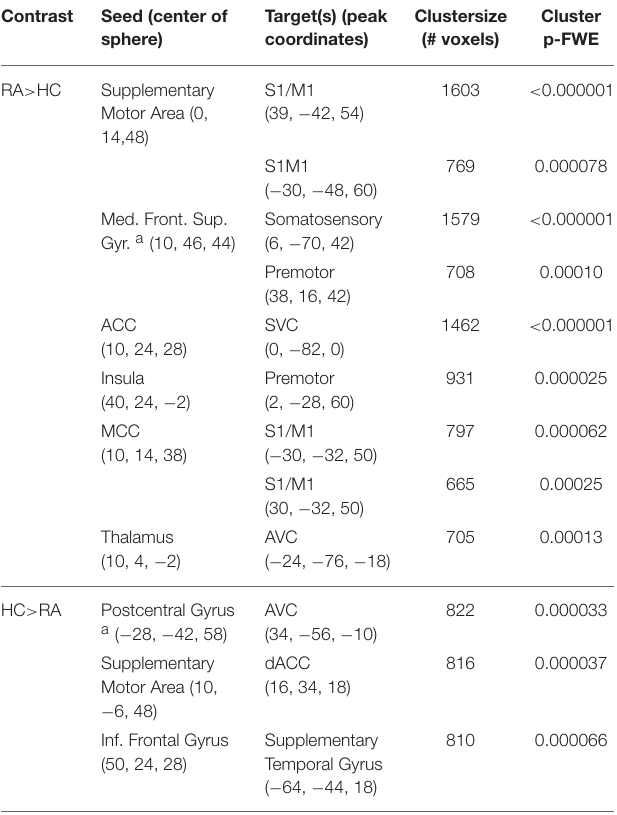
TABLE 2 | Group differences in functional connectivity.